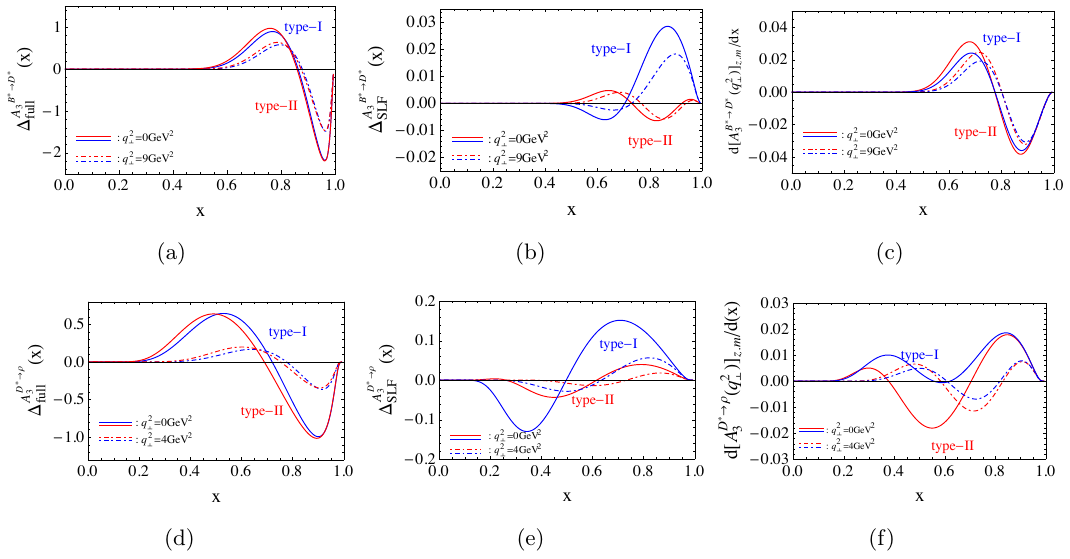
( x ), (cid:1) A 3 ( x ) and d[ A 3 ] z : m : = d x on x for B (cid:3) ! D (cid:3) transition SLF full = (0 ; 4) GeV 2 . See text for the detailed ?